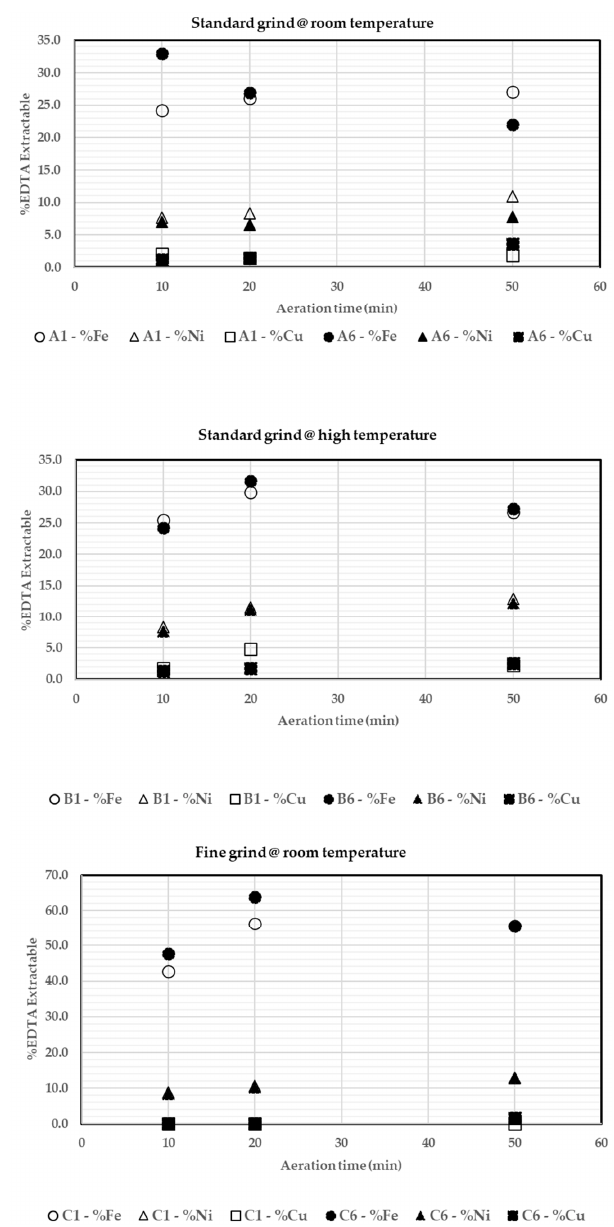
Figure 8. EDTA extractable metals as a function of aeration time.